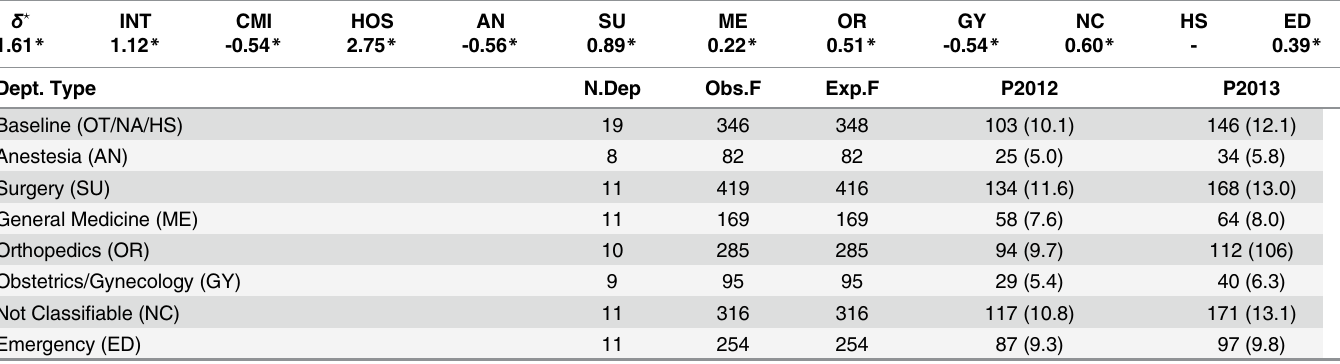
Table 7. Results for injuries, for the Toscana region. Estimates of the parameters of the Poisson model as per Appendix 2.1, number of departments of a given type that generated each alleged type of claim (N.Dep), observed frequencies of claims for the different types of departments (Obs.F), expected fre- quencies according to the model (Exp.F), and predicted claims for 2012 (P2012) and 2013 (P2013), together with their standard deviations (in